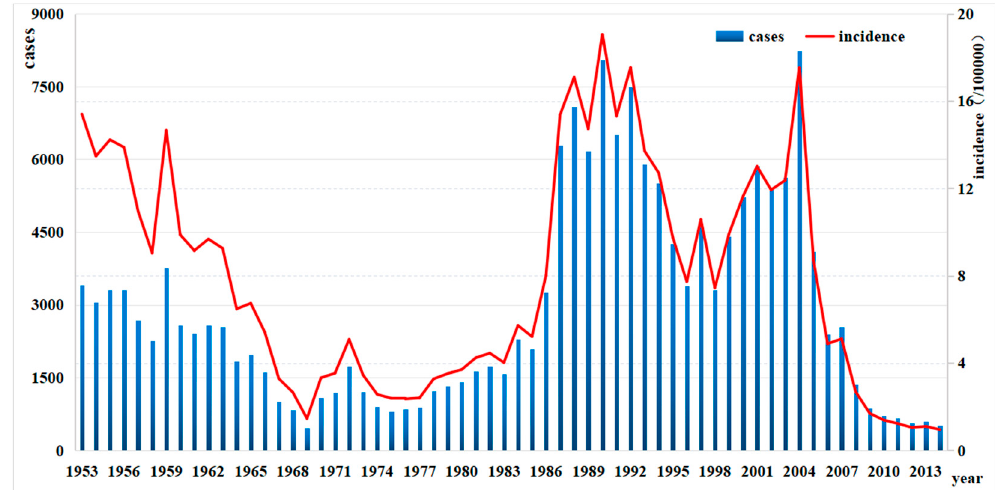
Figure 2. Cases and incidence trend of typhoid and paratyphoid in Zhejiang from 1953 to 2014.